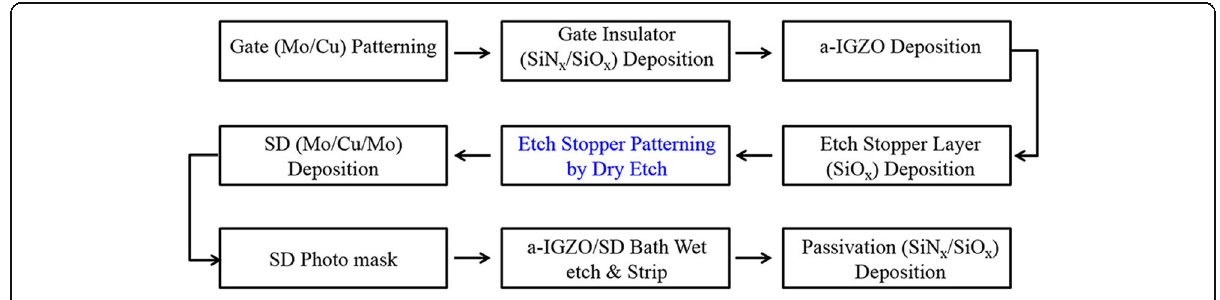
Fig. 1 Fabrication process of the a-IGZO GOA